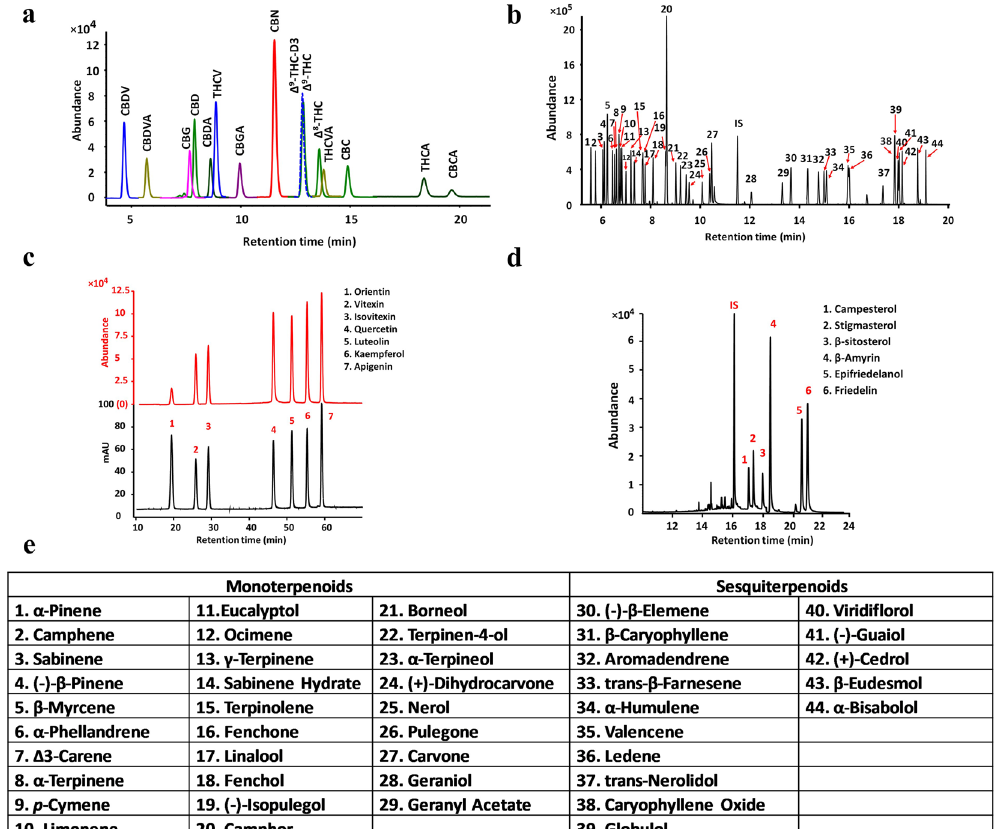
Figure 3. Chromatograms for cannabinoids, mono- and sesquiterpenoids, flavonoids, sterols, and triterpenoids. ( a ) Chromatogram for a standard solution of 14 mixed cannabinoids by LC-ESI-MS. ( b ) Chromatogram for 44 mono- and sesquiterpenoids by GC-MS. Terpenoids corresponded to the labeled number are listed in e . ( c ) Chromatogram for 7 flavonoids by HPLC-UV-MS. Mass spectrometry was used for flavonoid identification and UV detector was used for flavonoid quantification. ( d ) Chromatogram for 3 sterols and 3 triterpenoids by GC-MS. ( e ) Compound names for 44 mono- and